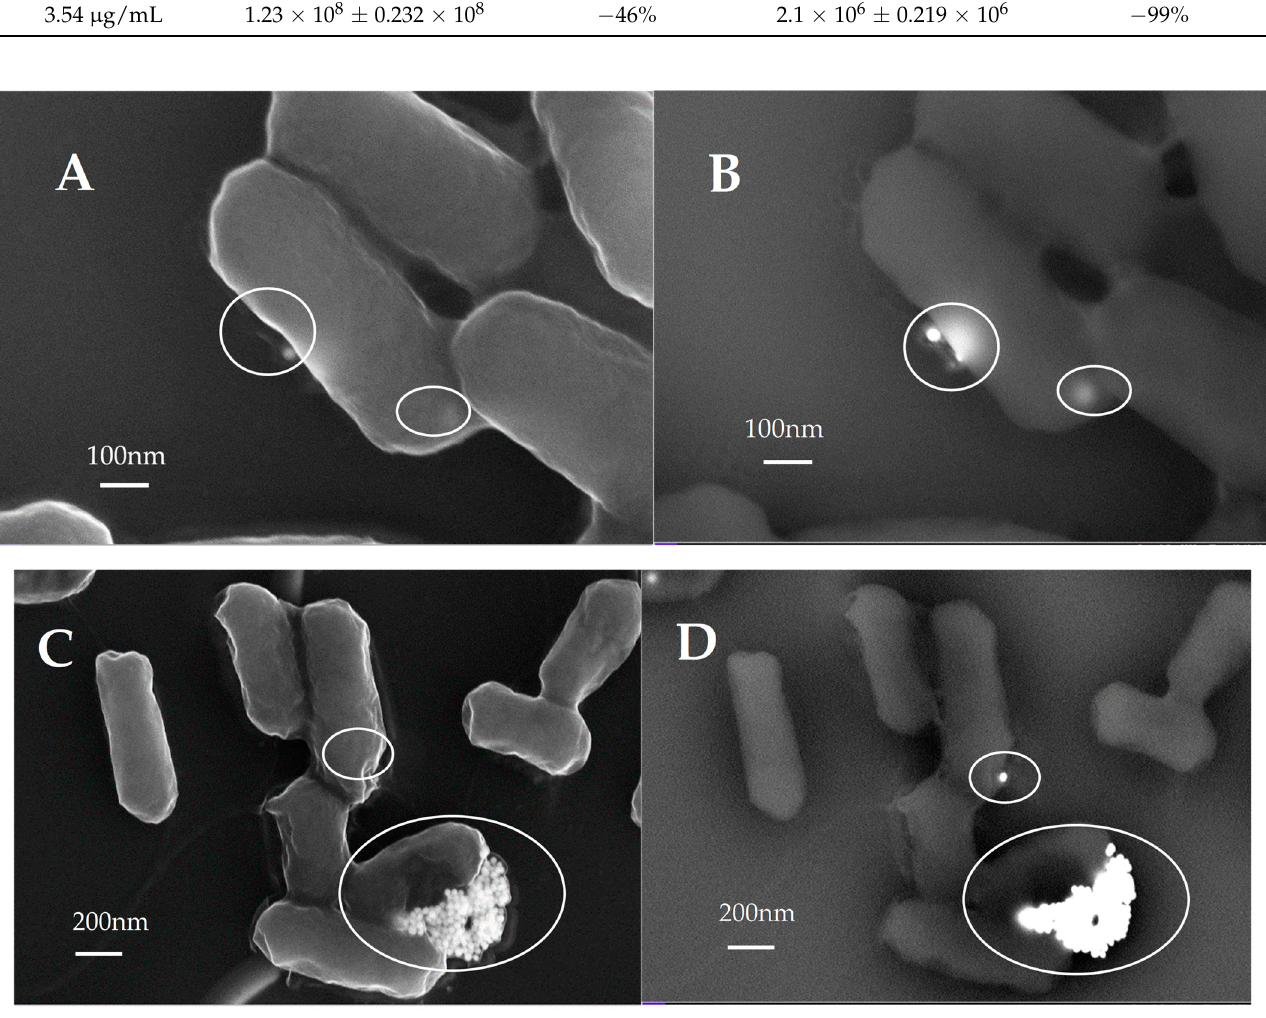
Figure 2. Secondary electrons (on the left) and backscattered electrons (on the right) paired images demonstrating the uptake of AuNP (3.54 µg/mL) in both non-irradiated ( A , B ) and irradiated ( C , D ) E. coli cells. Irradiated E. coli cells show greater pleomorphism (rough surface) and shrinkage in size because of increased cell death. Large aggregates of AuNP adhere onto the cell surface.